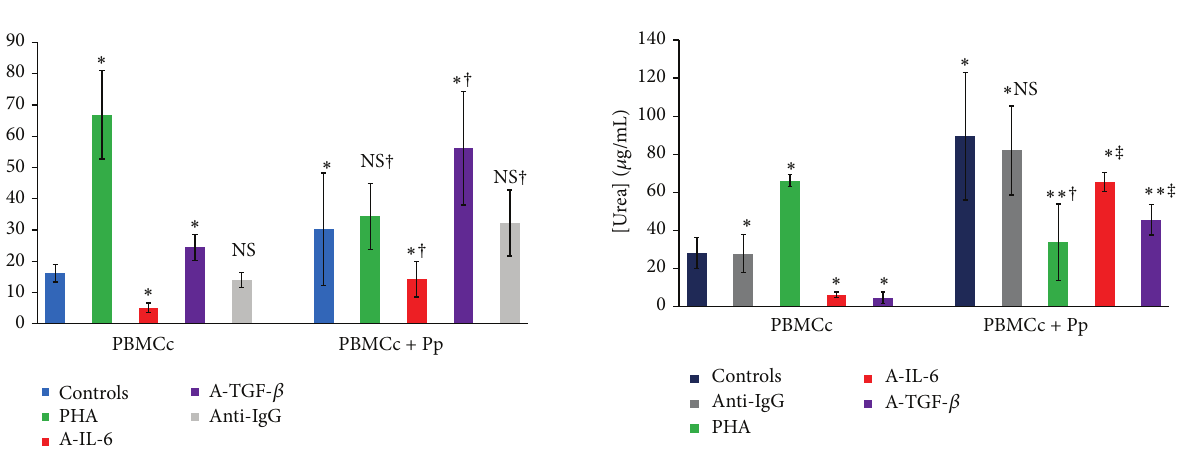
Figure 4: Patients plasma effect on urea production by cultured controls’ PBMC ( 𝑛 = 23 ) (ns: 𝑃 > 0.05 ; ∗ : 𝑃 < 0.05 versus control cultures without induction; ∗∗ : 𝑃 < 0.01 versus control cultures withoutinduction; † : 𝑃 < 0.05 versusculturewithoutPp; ‡ : 𝑃 < 0.01 versus culture without Pp) (PBMCc: controls’ PBMC, Pp: patients’ plasma, A-IL-6: anti-IL-6, A-TGF-beta: anti-TGF- 𝛽 , and anti-IgG: isotype control